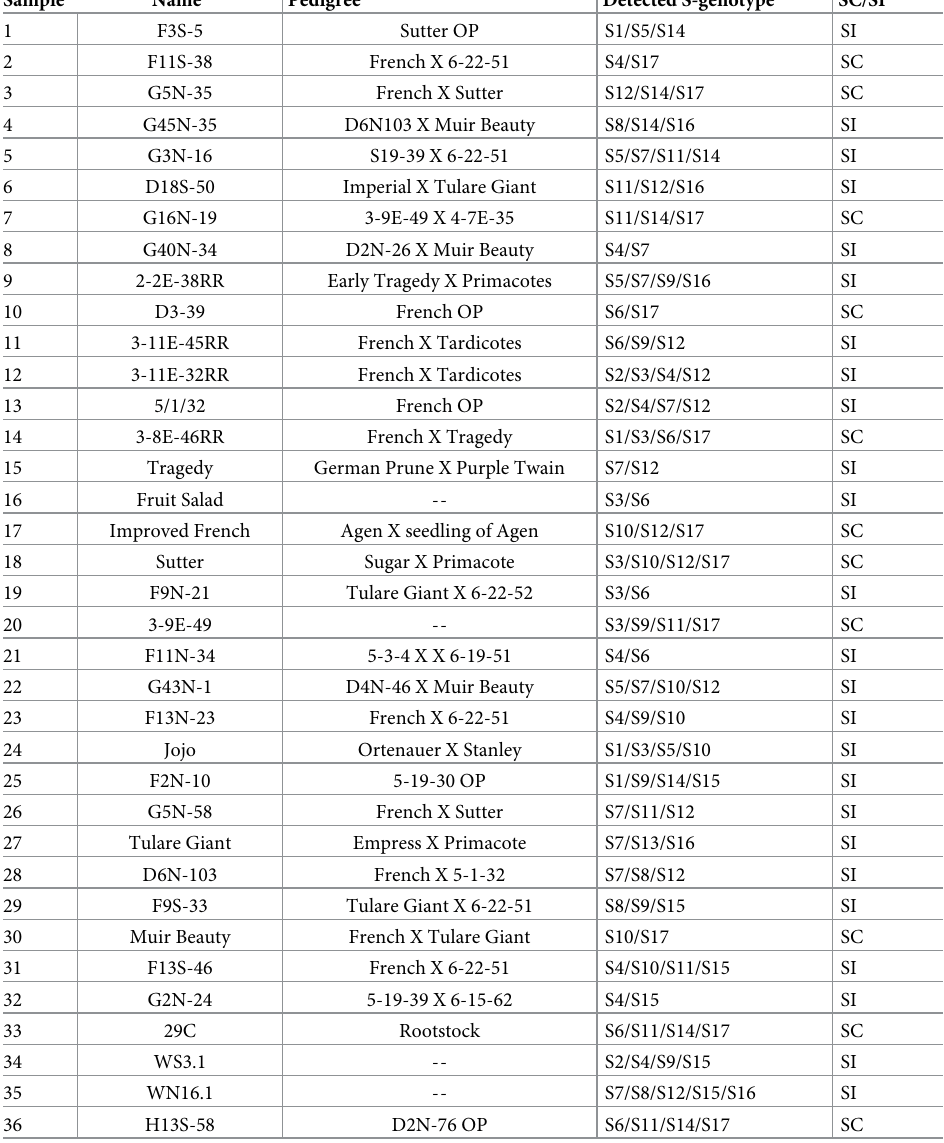
Self-compatible (SC) and self-incompatible